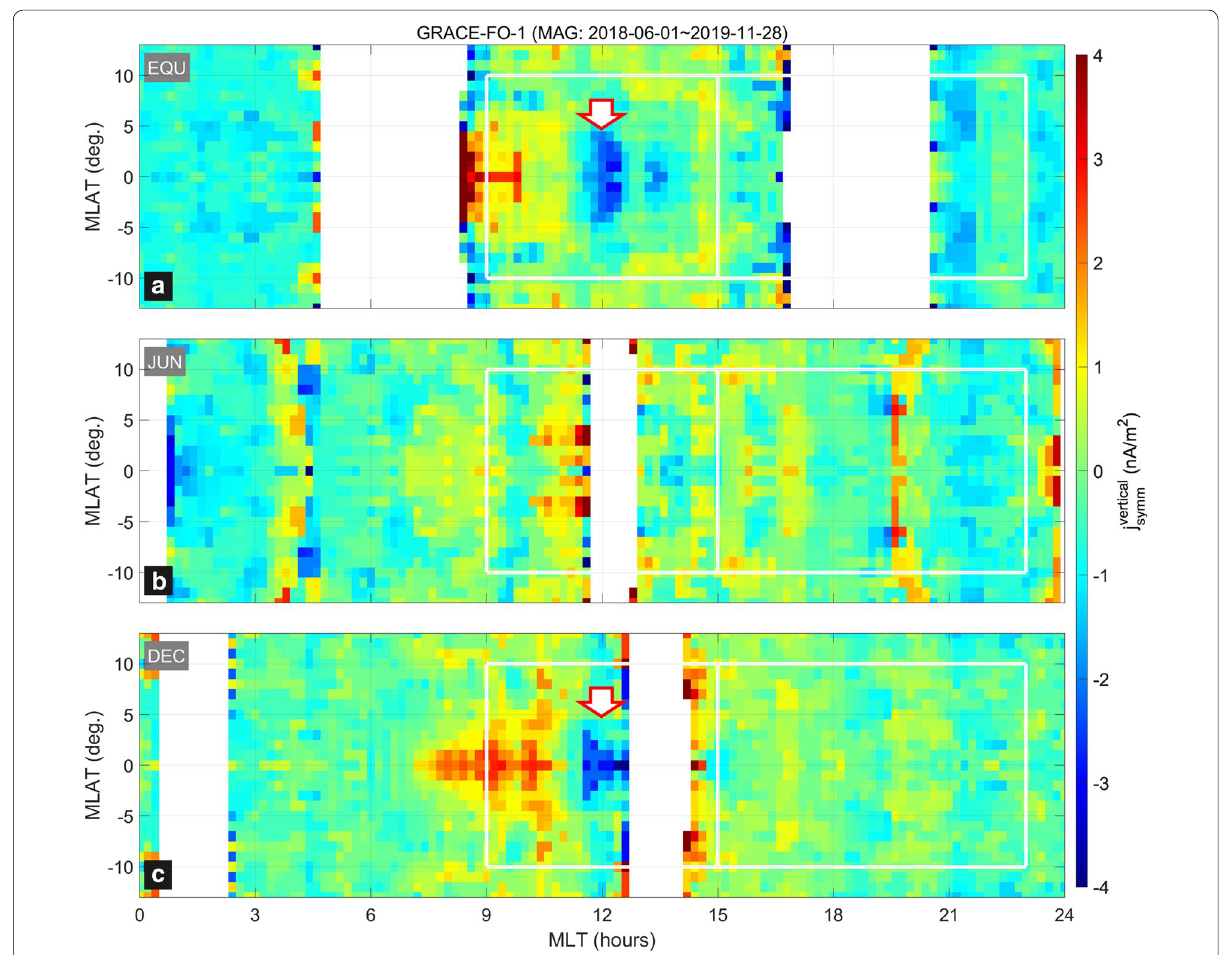
Fig. 5 The same as Fig. 4, but from